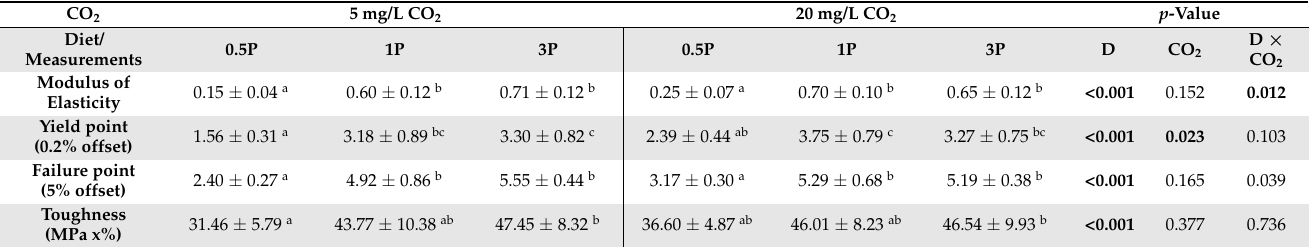
Table 8. Mechanical properties of vertebral centra. Analyzed mechanical properties were corrected for size of the vertebral centra. Three animals per tank (six/group) were measured at week 16. Animals were fed different levels of total phosphorus (P) 0.5P (6.3 g/kg), 1P (9.0 g/kg), and 3P (26.8 g/kg) and reared in conditions with no CO 2 injected (5 mg/L) or with injected CO 2 (20 mg/L). The statistically significant differences among groups (within a row) are indicated by different lowercase superscript letters. If none of the letters are the same, differences are significant. The significant values ( p ) for CO 2 , diet (D), and their interaction are